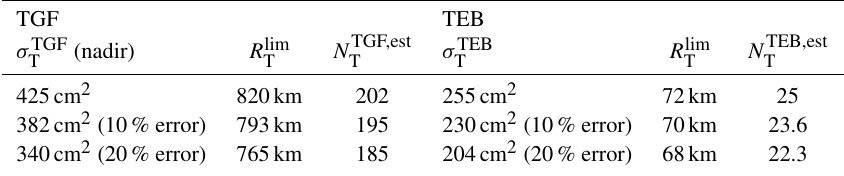
(cid:16) (cid:17) n min on the limit radius T